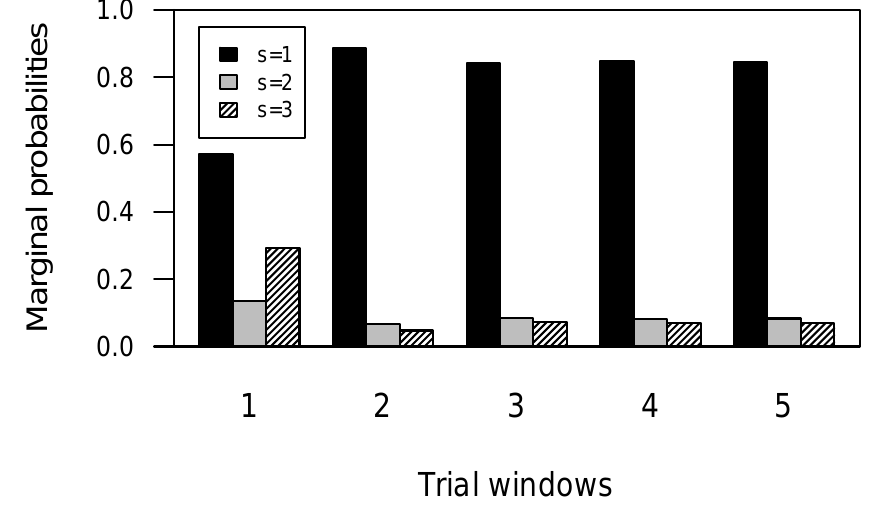
Figure 4. Marginal distribution of the latent states for each task phase, for the Control group.